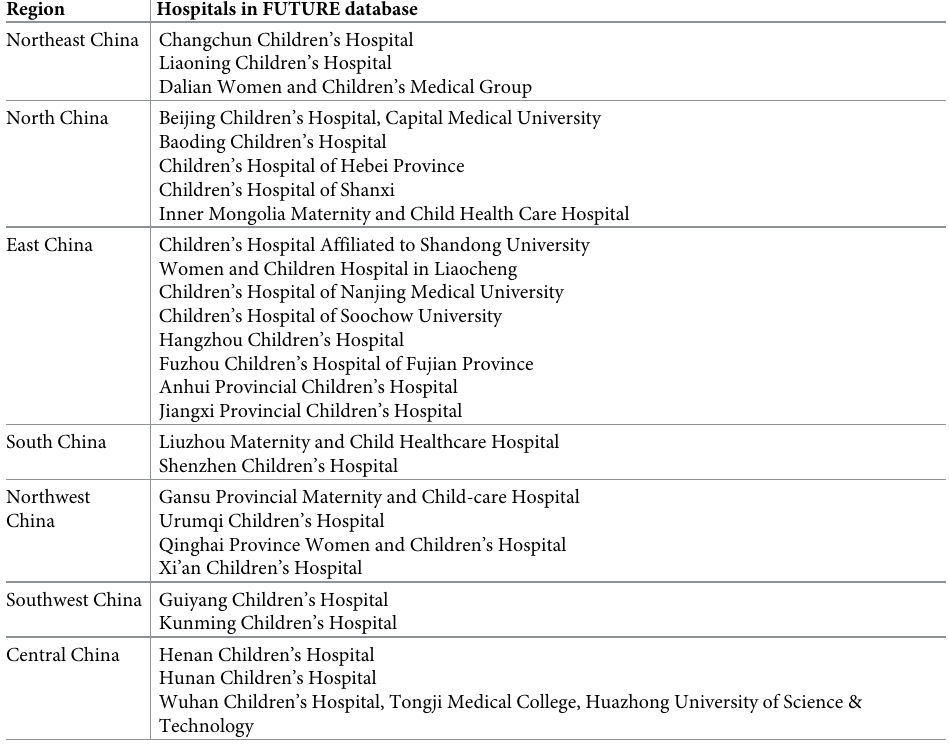
Table 1. The geographic distribution of 27 children’s hospitals in the FUTang Updating medical REcords (FUTURE) database.